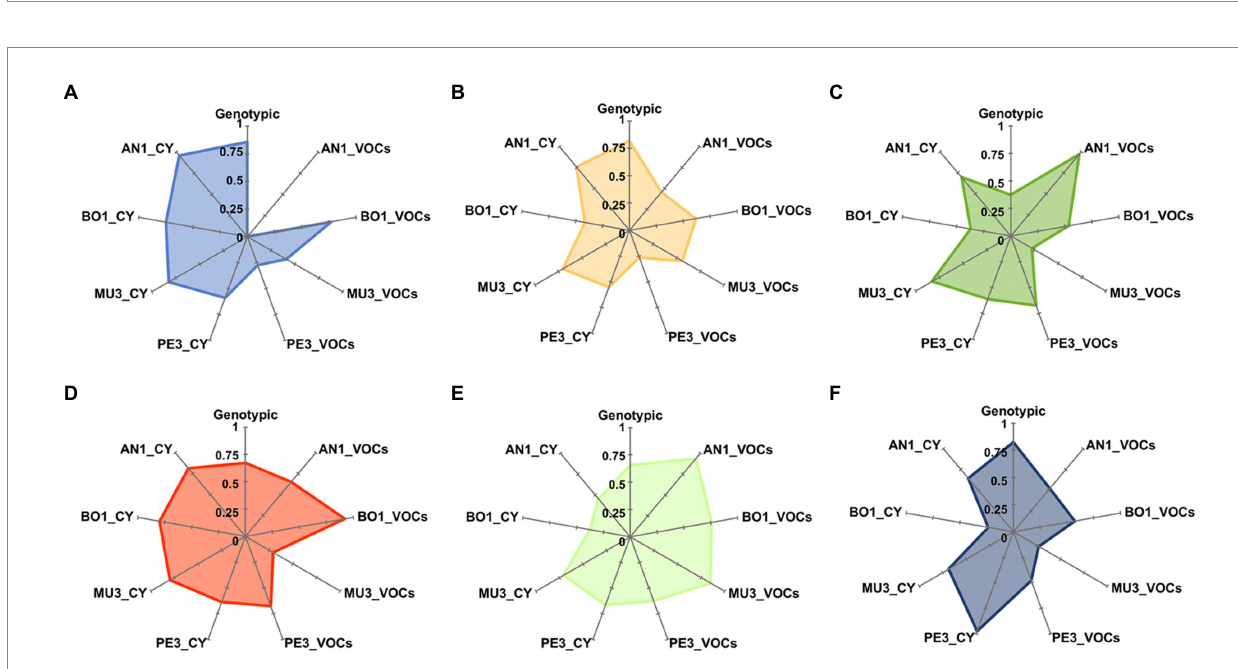
FIGURE 3 Radar plots of genotypic and antagonistic activity diversity indexes. For the most representative yeast genera, Aureobasidium (A) , Starmerella (B) , Lachancea (C) , Hanseniaspora (D) , Saccharomyces (E) and Metschnikowia (F) , Pielou’s J’ evenness index was calculated based on groups defined at 80% similarity level on dendrograms constructed, using Pearson correlation coefficient and UPGMA of the PCR fingerprinting profiles (Supplementary Figure S4) and of the mold response profiles (Supplementary Figure S3). AN1, Aspergillus nige r; BO1, Botrytis cinerea ; MU3, Mucor sp.; PE3, Penicillium sp.; CY, diffusible compounds assay; VOCs, volatile compounds